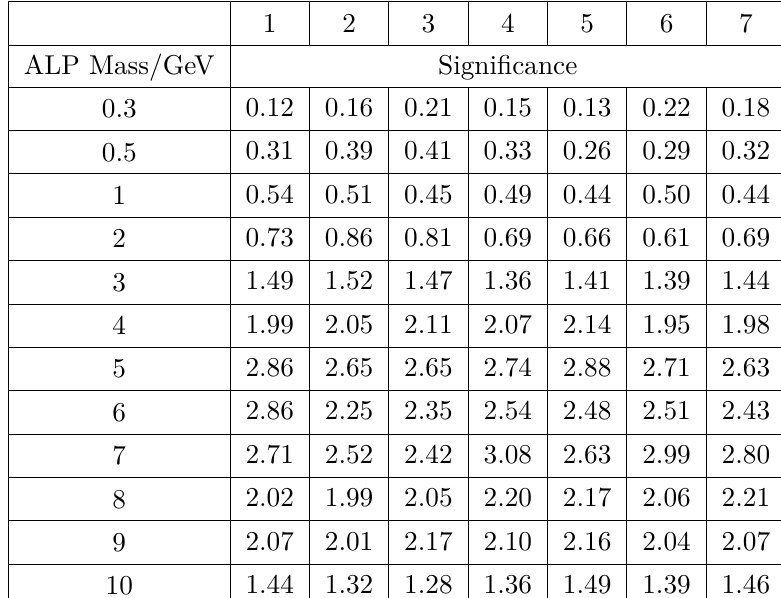
Table 4 . The optimal significance for the ALP-strahlung production process pp → W ± a obtained from the trainings of seven significance neural networks. The benchmark point is chosen as g 0 . 64 TeV − 1 .